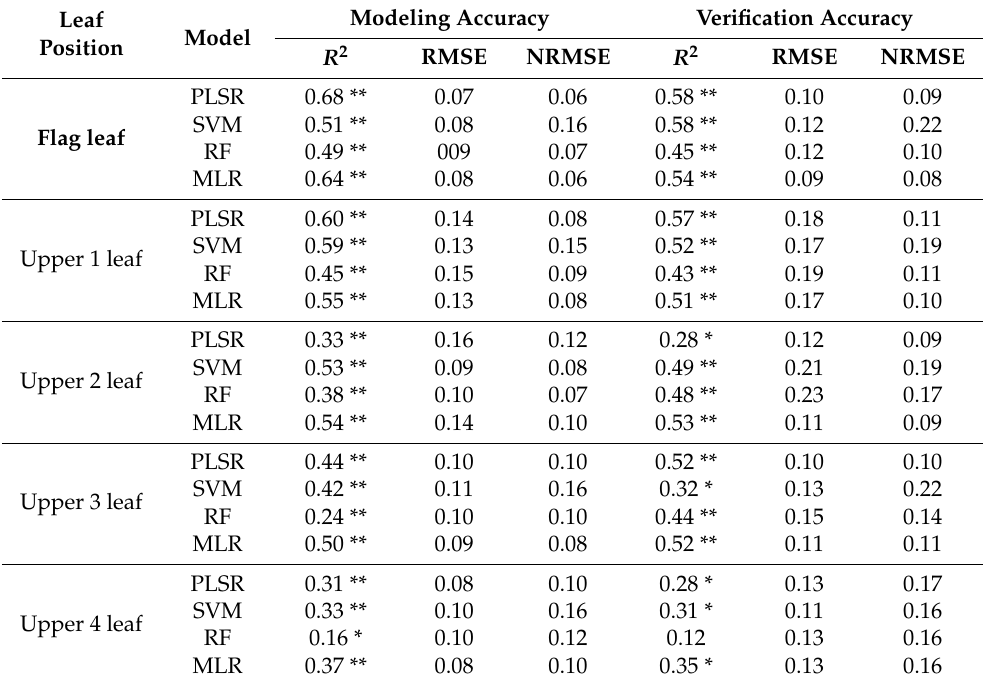
Table 5. Model accuracy of estimating nitrogen content based on vegetation